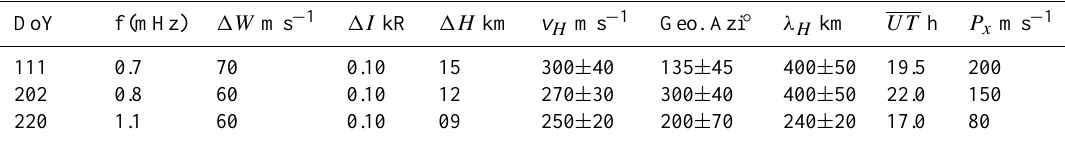
Table 1. Derived wave